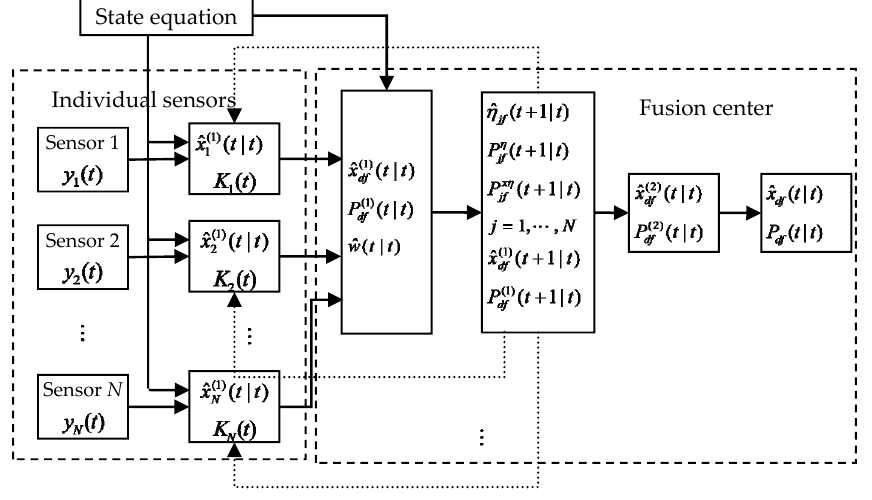
Figure 1. Globally optimal DFFWF.